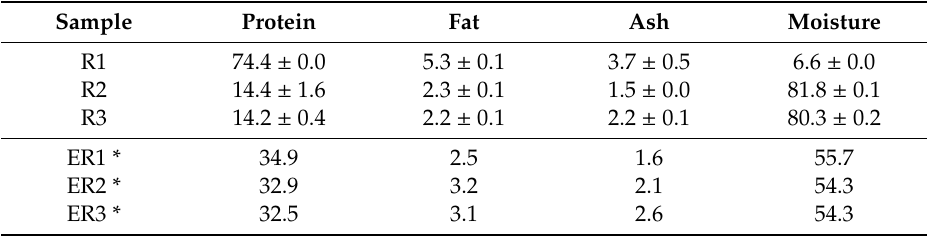
Table 1. Measured chemical composition of the raw materials (R1–R3) and calculated composition of the extrusion mixtures (ER1–ER3) (as is, %), where 1 indicates pea protein, 2 gutted fish and 3 whole